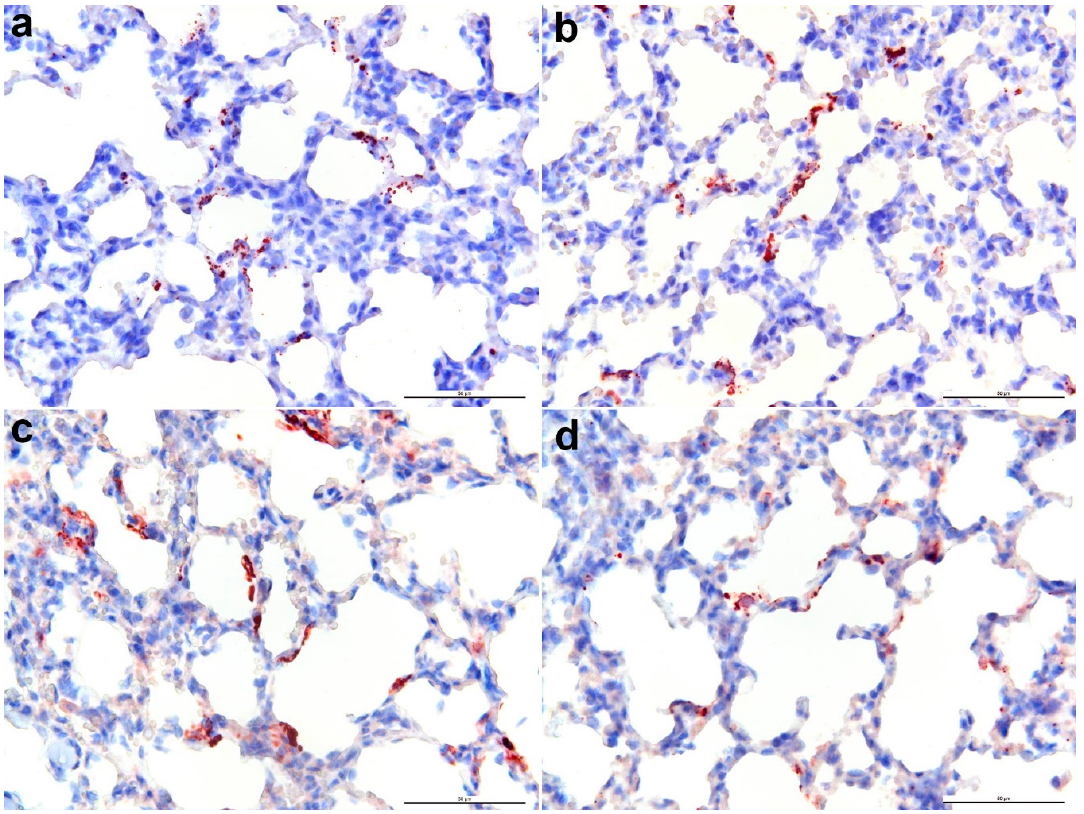
Figure 2. Immunohistochemical labelling of BTV infected sheep lung with BTV-specific antibodies. NS1 monoclonal antibody (mAb) 31D11 ( a ), NS2 mAb 30G4 ( b ), NS3/3a mAb 441 ( c ), and VP7 polyclonal antibody 20-3 ( d ). Bar = 50 μ m.